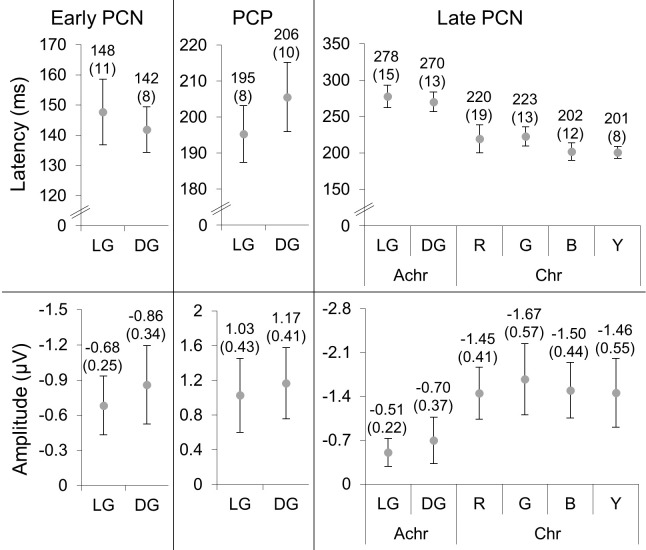
The latencies (top) and amplitudes (bottom) of the early PCN, PCP, and late PCN (left to right) detected in Experiment 1. The means and 2 standard errors (in brackets) are above each data point. The units are milliseconds and microvolts for the latencies and amplitudes, respectively.